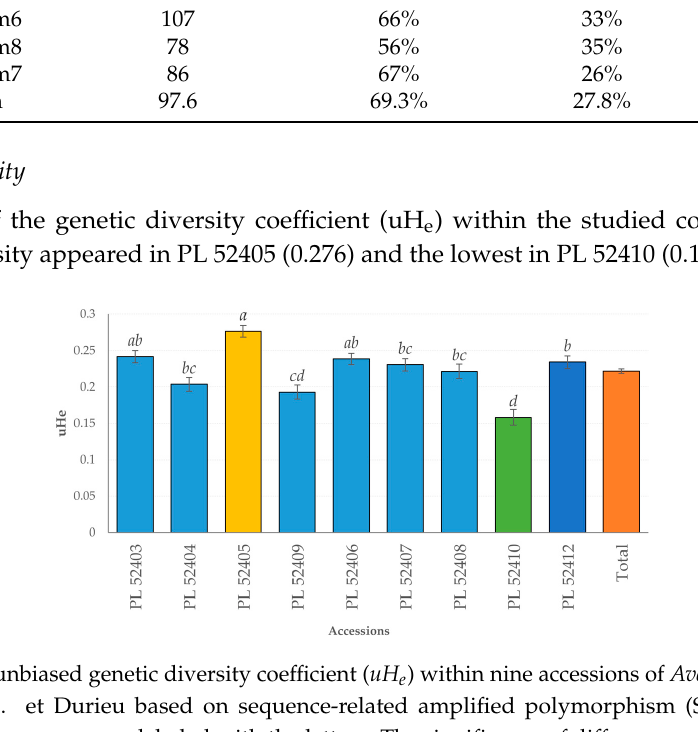
Figure 4. The results of the Principal Coordinates Analysis (PCoA) of nine accessions of Avena macrostachya Bal. ex Cross. et Durieu based on sequence-related amplified polymorphism (SRAP) markers.